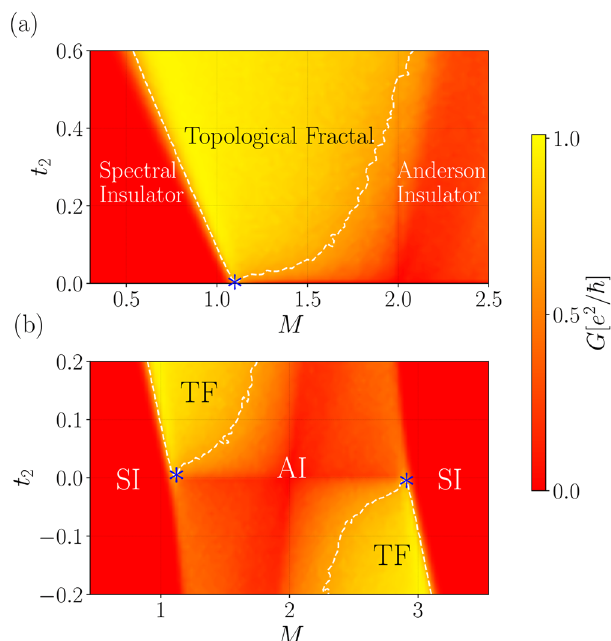
Fig. 2 Topological phase diagram of the random fractals. a Phase diagram of the studied systems as a function of the second-nearest-neighbour hopping t 2 and the mass parameter M , obtained by calculation of the two- terminal conductance G for half- fi lled square-shaped systems with linear dimensions L = 150. The dashed white line represents the approximate critical surface G c = 0.65, which encloses the topological regime where G → 1 in the thermodynamic limit L → ∞ . The blue star signi fi es the tricritical point at t 2 = 0 and M c ≈ 1.1 and the colour bar indicates the value of G . Data is averaged over 650 independent random realizations. b Same as ( a ) but for an extended parameter regime. Here L = 120 and data is averaged over 800 con fi